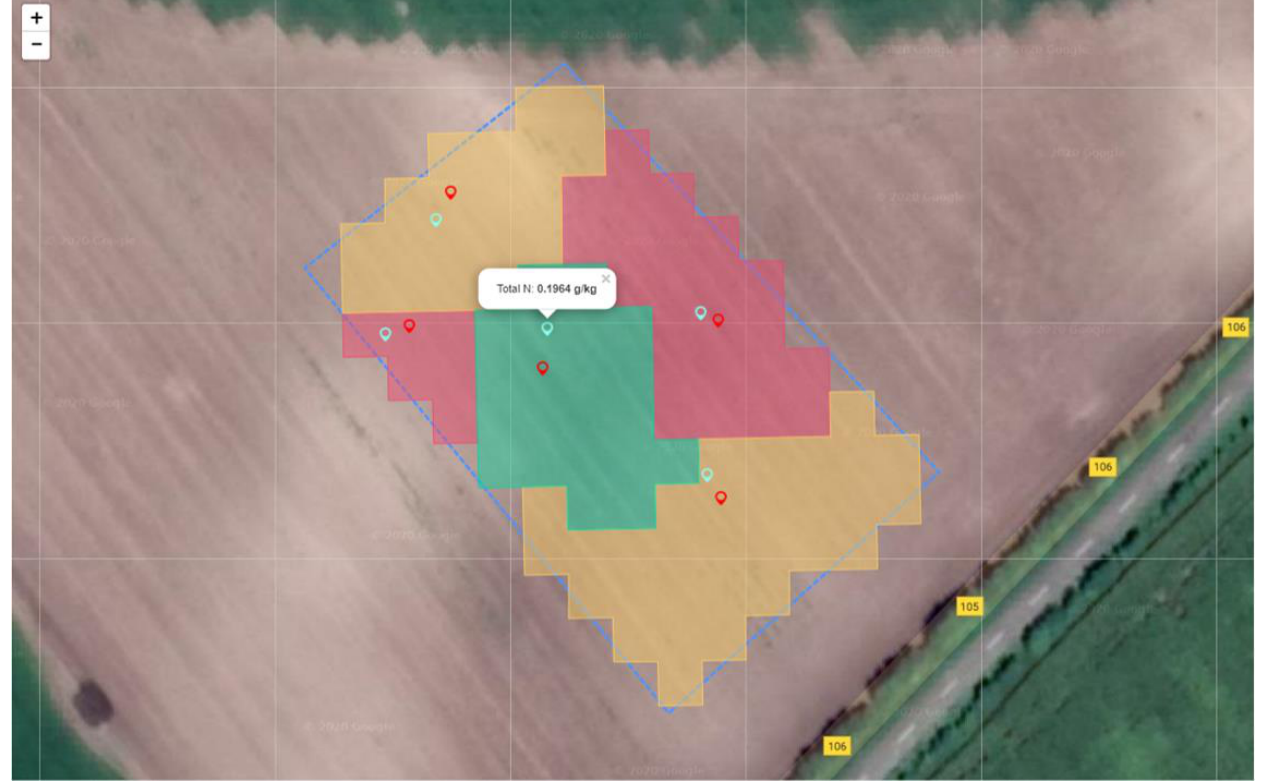
Figure 15. Fertilization prescription map generated based on the measurement results. Red pins represent proposed sampling locations by AI algorithm, while green pins represent actual sampling locations.